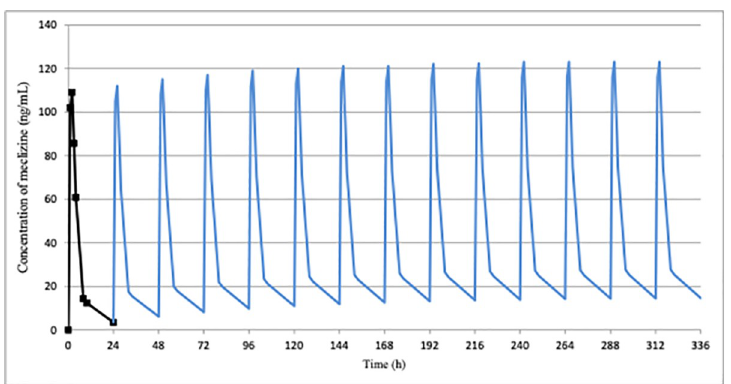
Fig 4. Simulated plasma concentration profile of meclizine at once a day for 14 days multiple administrations in ACH children. Plasma concentration simulated using the mean measured results after once a day administration of meclizine hydrochloride 25 mg tablet (body weight normalized) apparently reached steady state around 10 days after the first dose.